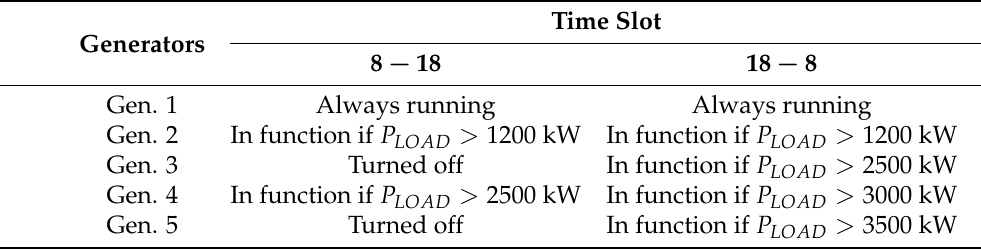
Table 2. Control logic of diesel groups during summer.